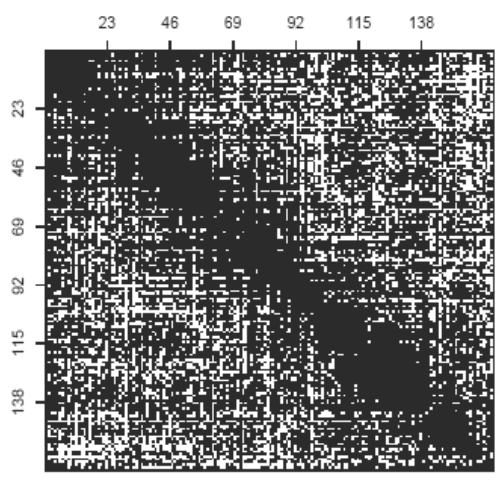
Figure 5 – Adjacency matrix of the graph selected by the qp -procedure with q =20 and * β = 0.975. Black points are present edges (value 1 in the adjacency matrix) and white points missing edges (value 0 in the adjacency